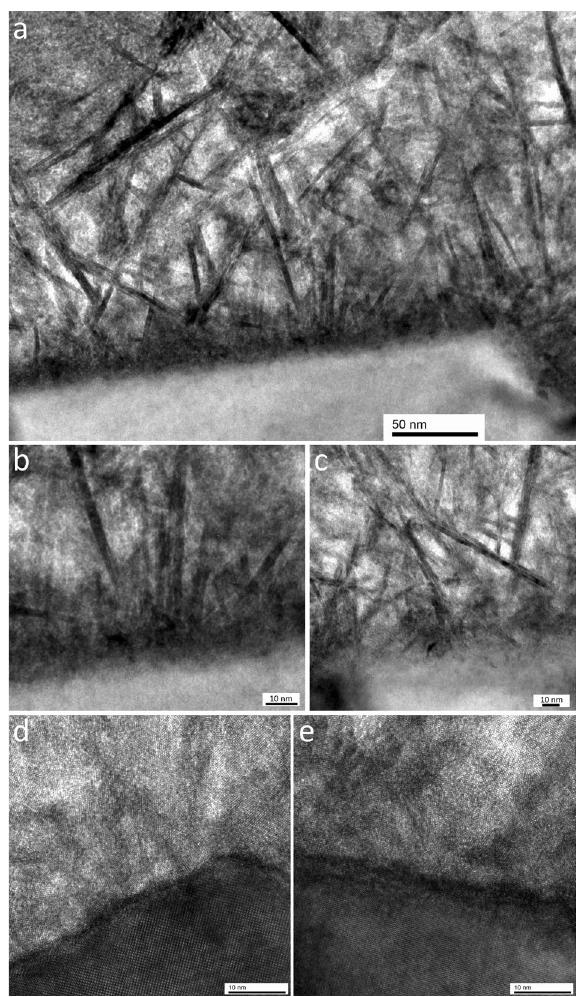
Figure 10. ( a ) Cross-sectional TEM image of the interface between the SnO 2 nanosheet and the FTO layer. ( b , c ) Magnified images showing the crystal growth of the SnO 2 nanosheets at the initial stage. ( d , e ) High- resolution images showing the crystal lattice fringes of the SnO 2 nanosheets and the FTO